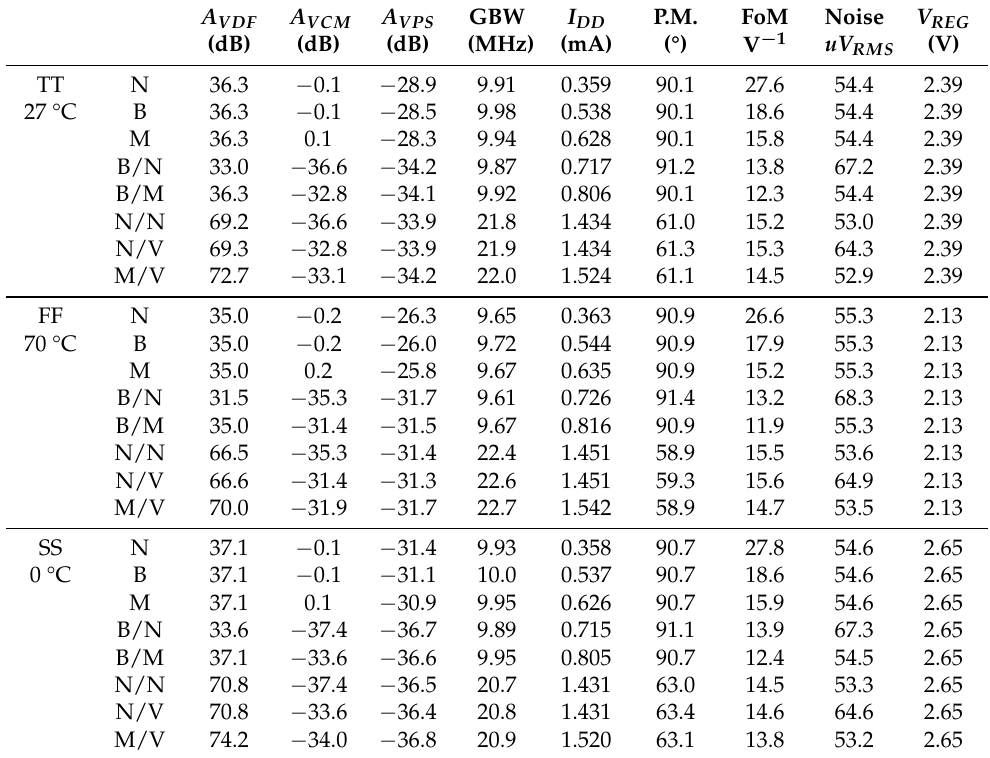
Table 3. OTA PVT simulation